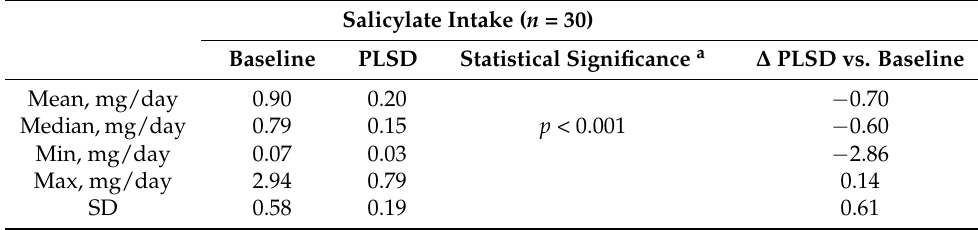
Table 3. Intake of dietary salicylates before and after dietary intervention among study participants.